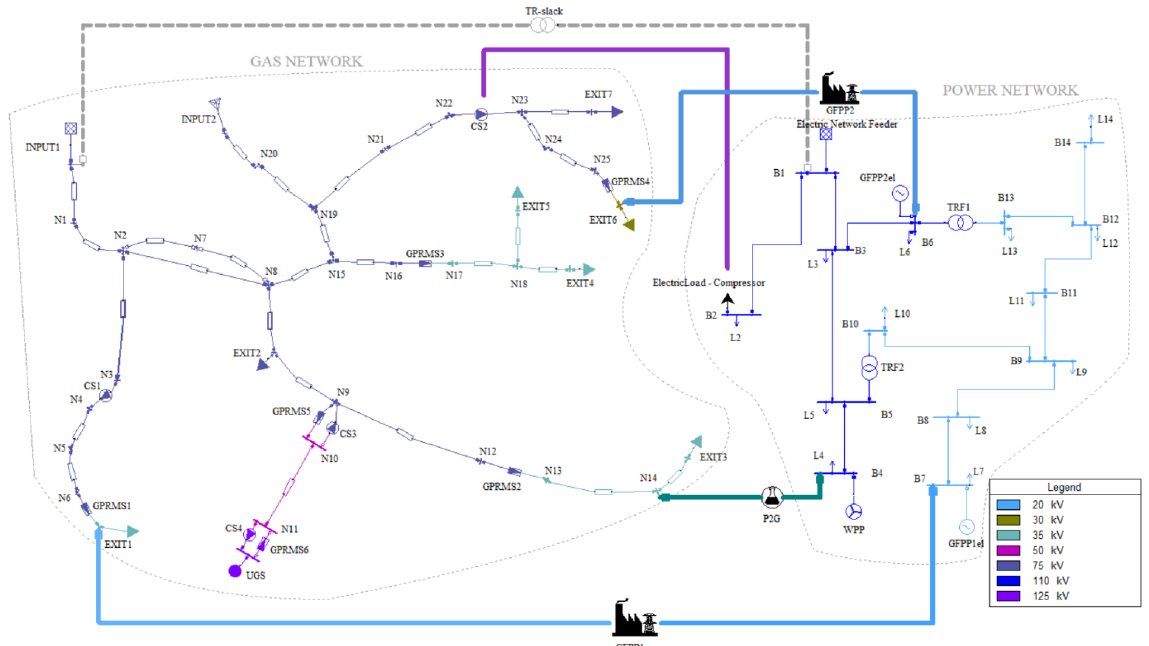
Figure 4. A unique electrical MES model developed in NEPLAN. The parameters of electric lines and loads were given in Tables 7 and 8, respectively. The total length of the power network was 285 km, and all lines were overhead types. Table 7. Electric line parameters.